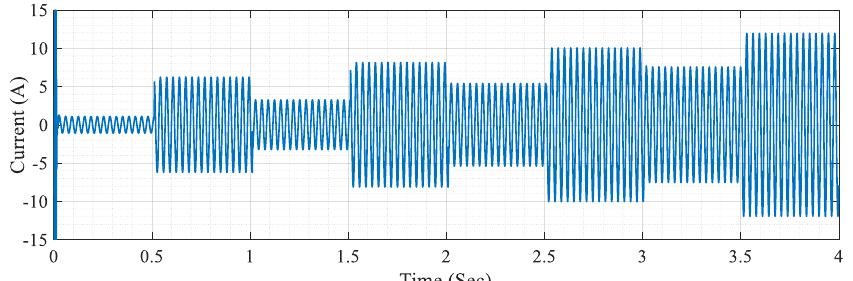
Figure 13. The instantaneous currents of phase A in case of fault at constant frequency of 30 Hz and current variation from 0.75 A to 3 A with step of 0.75 A.